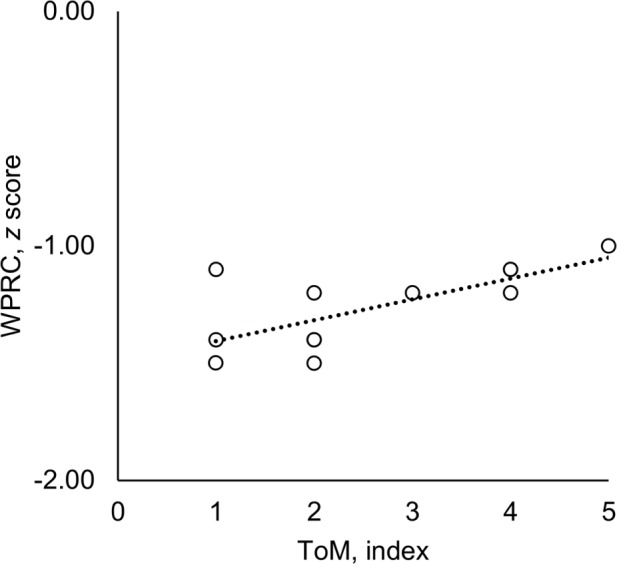
Association between ToM and z-score on Woodcock Passage Reading Comprehension (WPRC; z-scores are calculated based on the norm values for Grade 1 hearing children from Furnes and Samuelsson, 2009, i.e., 0 represents mean performance of Grade 1 hearing children, SD = 1). Regression line (dotted) represents the strength of relationship between variables.